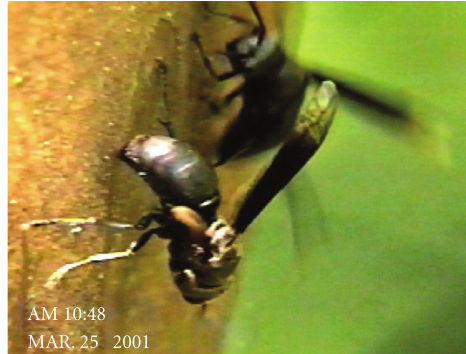
Figure 2: Scouts of Pa. fraternus from colony C2 spraying venom on the substrate at the new nest site prior to population departure from the original